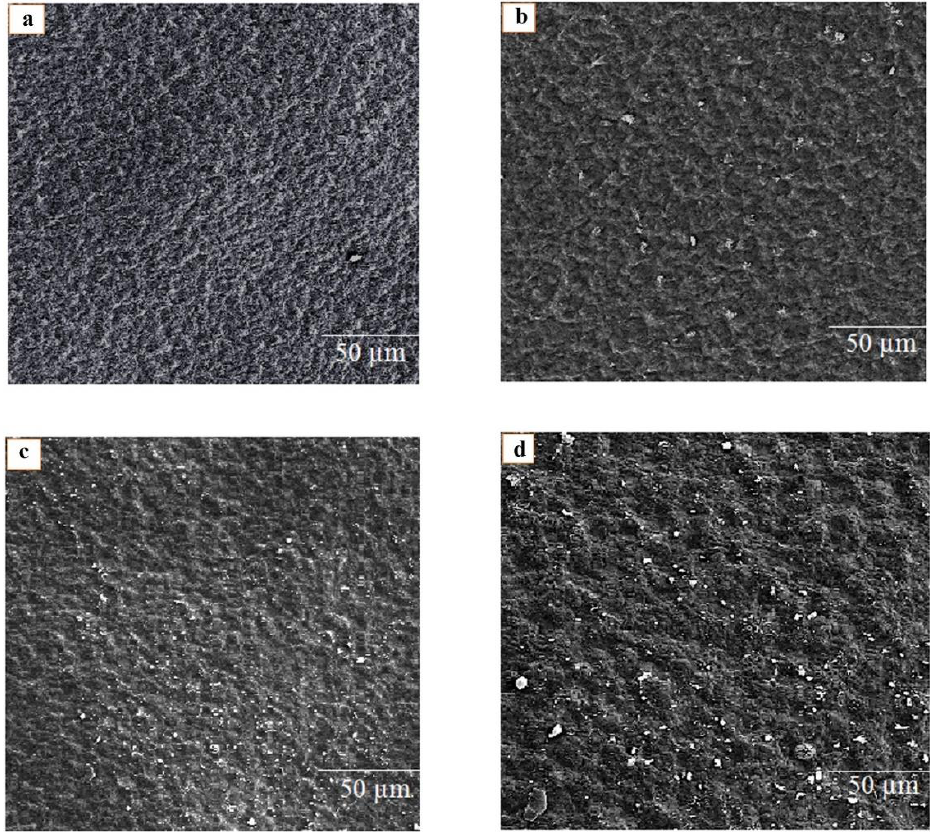
Figure 2. FE-SEM images of G/PVA ( a ), G/PVA/CWE 9 ( b ), G/PVA/MEO 9 ( c ), and G/ PVA/CWE 9/MEO 9 ( d ) active films.